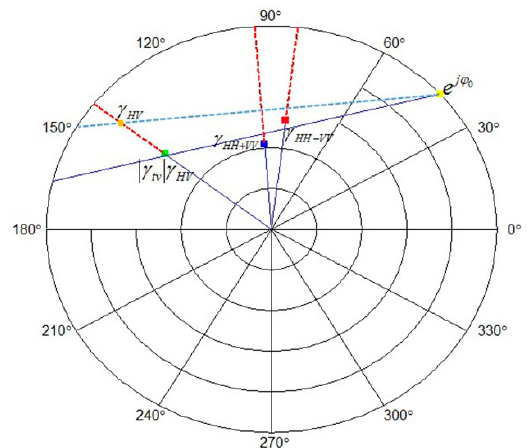
Figure 6. Geometrical interpretation of the effect of the volume temporal decorrelation multiplying factor. The coherence loci in the RVoG and RVoG+VTD models have been shown in solid blue and dotted blue lines. The dotted red lines show the ambiguous radial segment for Pauli basis coherences.